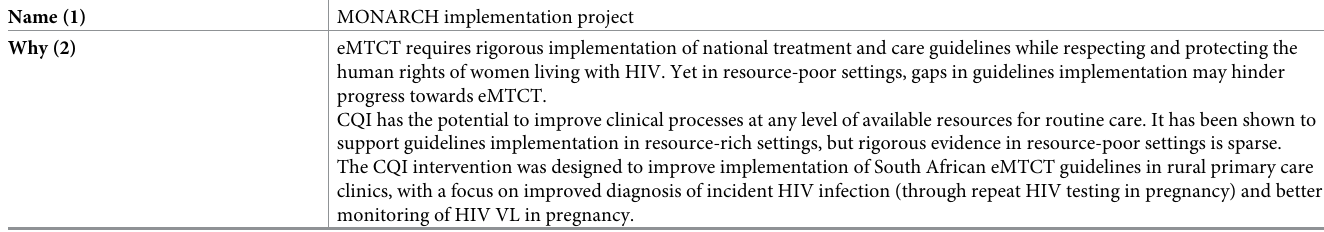
Table 1. MONARCH CQI intervention description: TIDieR